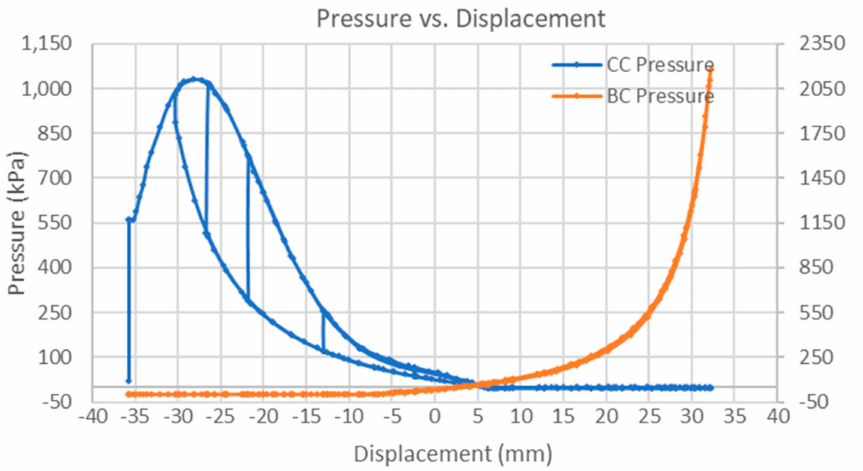
Figure 6. No-load operation: pressure vs. displacement profile for CF = 0.38. Increasing the CF further to 0.50, the endpoint displacements in both CC and BC continued to go deeper inside, as can be seen in Figure 7. It was observed that the compression pressures of the return strokes in CC were so high that the compression profiles intersected and even increased beyond the combustion profiles. The piston was shown to be able to attain the required combustion and compression pressures for continuous and sustained operation. At this value of CF, energy from combustion was enough to provide for the rebound process in the BC, the compression process in the CC and for frictional and system losses, such that continuous operation was